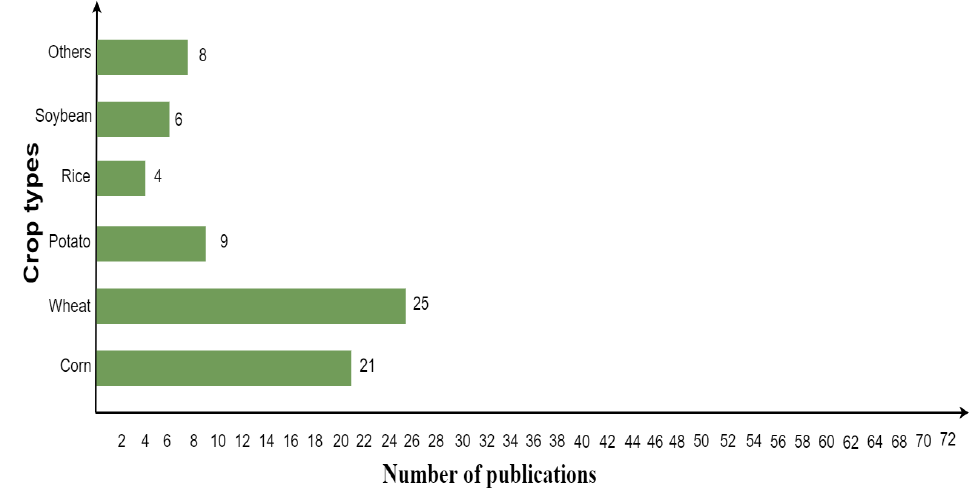
Figure 8. The most investigated crops using hybrid inversion model.